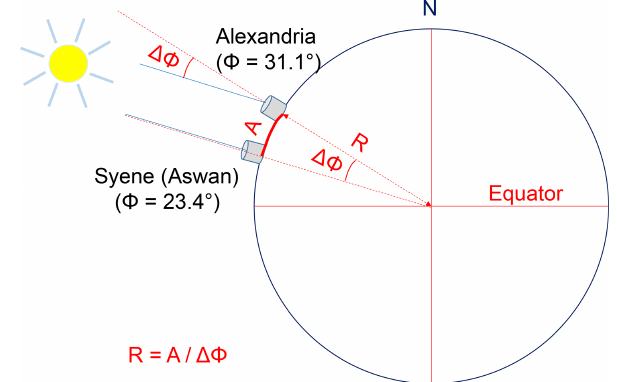
Figure 1. Eratosthenes’ method of determining the radius of a spherical Earth. At the summer solstices the Sun is mirrored in a wa- ter supply well in Syene (today’s Aswan High Dam), but in Alexan- dria, located on the same meridian, the Sun is casting a shadow with a length corresponding to an angle of (cid:49)(cid:56) = 7 . 7 ◦ , i.e. the latitude difference between both locations. Measuring the distance from Alexandria to Syene (arc A) yields the Earth’s radius R = A/(cid:49)(cid:56) .